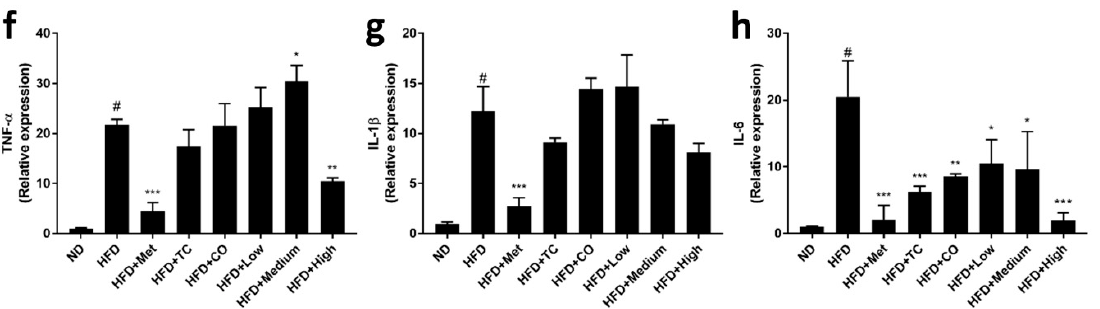
Figure 1. Effects of CO/TC formulations on ( a ) body weight, ( b ) body weight gain, ( c ) epididymal fat, ( d ) inflammatory index of adipose tissue, and ( e ) epididymal adipocyte microsections stained with H&E, and the relative expression of ( f ) TNF- α , ( g ) IL-1 β , ( h ) IL-6 in epididymal adipose tissue. Values are means ± SD for n = 6, and analyzed by one-way ANOVA with Tukey post-hoc test. # p < 0.05 was considered significant for ND vs. HFD. *** p < 0.001, ** p < 0.01, * p < 0.05 vs. HFD group. NS, represents no significance difference ( p > 0.05).